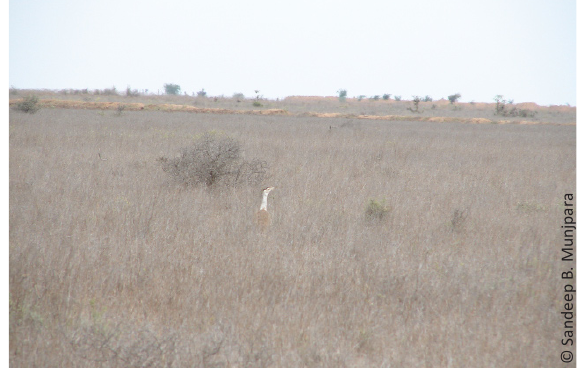
Image 2. Grassland: more preferred Cymbopogon martinii grass community